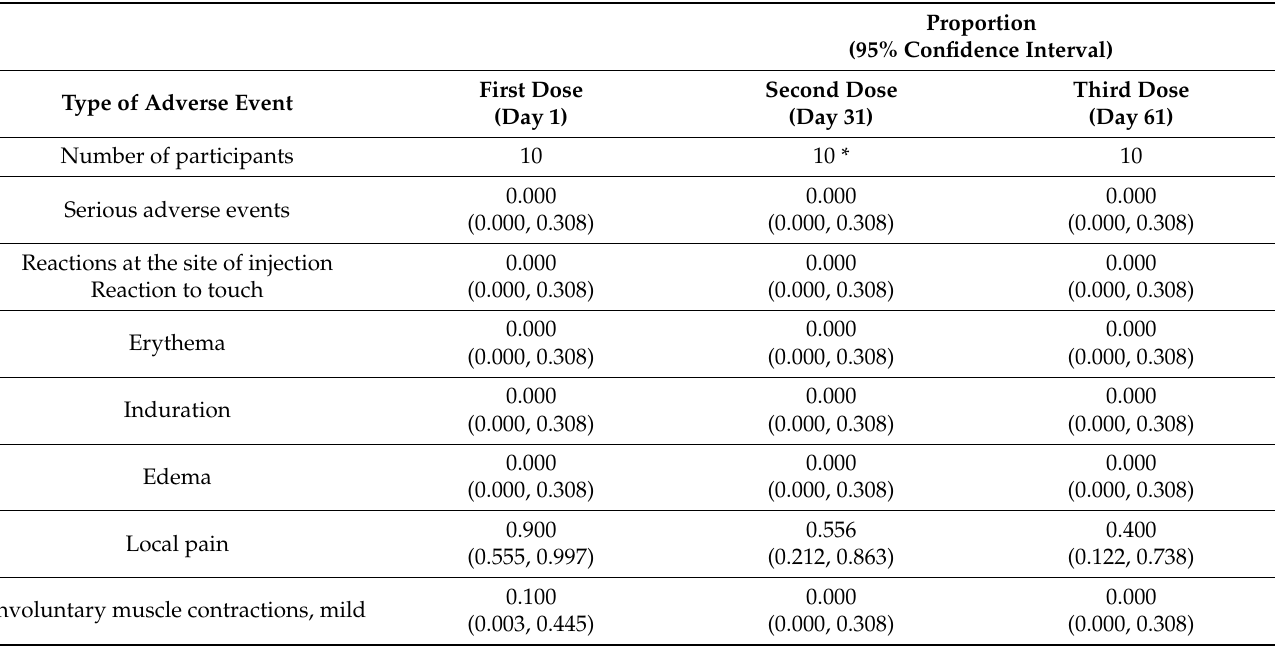
Table 2. Adverse events related to the injection of the vaccine: reactions at the site of injection and systemic reactions during the first 36 h after the administration of the vaccine.